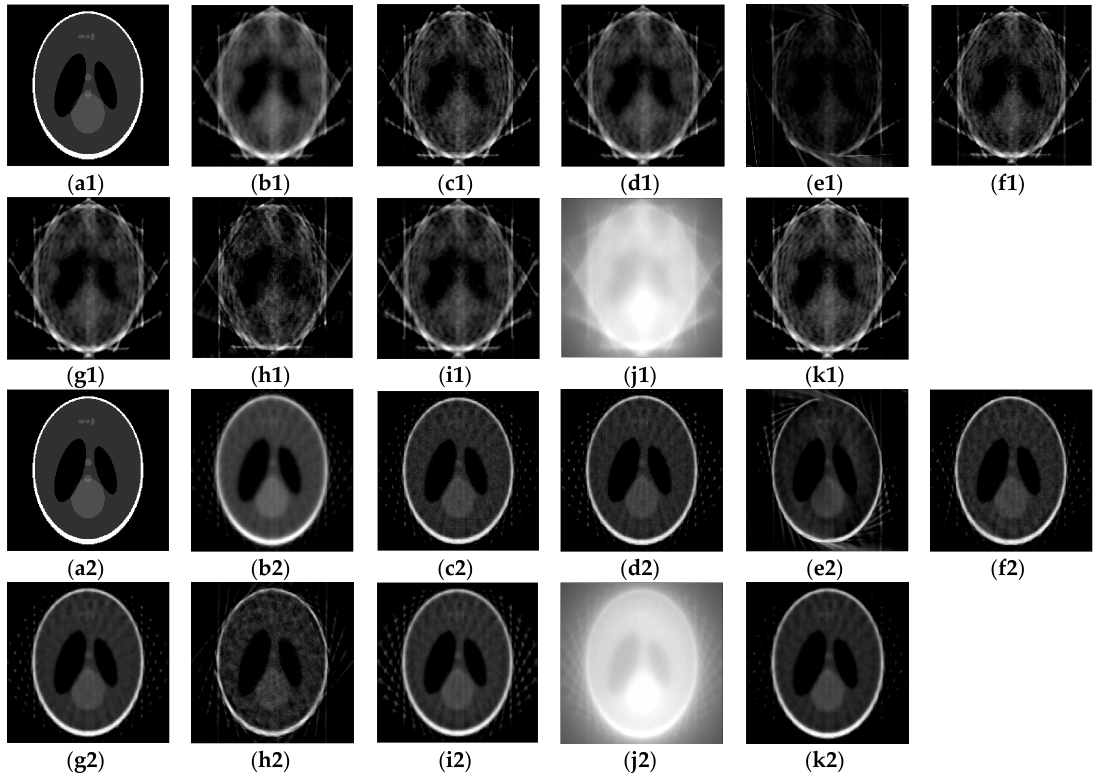
Figure 3. The Shepp–Logan phantom reconstructed results, based on sparse 12-projection input (from ( a1 ) to ( k1 )) and sparse 48-projection input (from ( a2 )–( l2 )), such as: ( a1 , a2 )–Origin phantom, ( b1 , b2 )–SIRT (simultaneous iterative reconstruction technique), ( c1 , c2 )–SART (simultaneous algebraic reconstruction technique algorithm), ( d1 , d2 )–OS-SART (order-subset SART), ( e1 , e2 )–TV-SART (total variation SART), ( f1 , f2 )–ASD-POCS (adaptive steepest descent projection onto convex sets), ( g1 , g2 )–OS-ASD-POCS (order-subset ASD-POCS), ( h1 , h2 )– β -ASD-POCS, ( i1 , i2 )–CGLS (conjugated gradient least square algorithm), ( j1 , j2 )–FISTA (fast iterative shrinkage-thresholding algorithm) and ( k1 , k2 )–